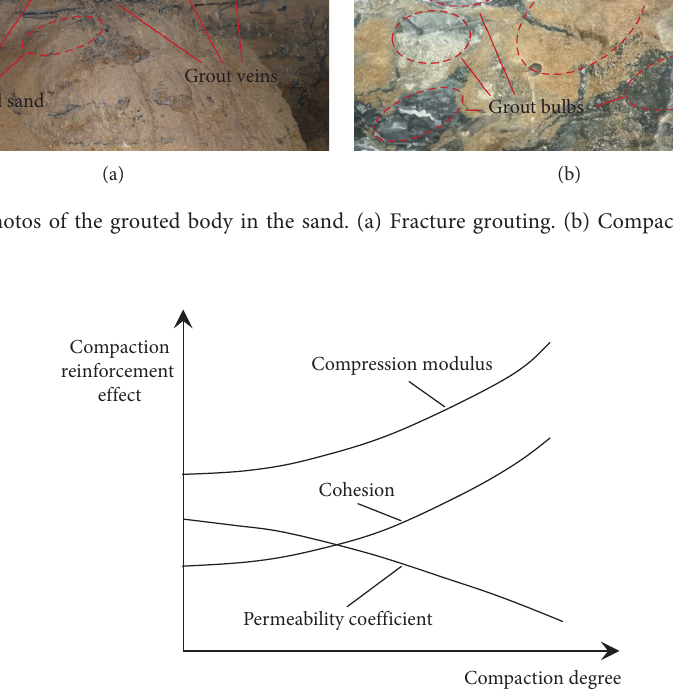
Figure 2: Relations of compaction reinforcement effect and compaction degree.